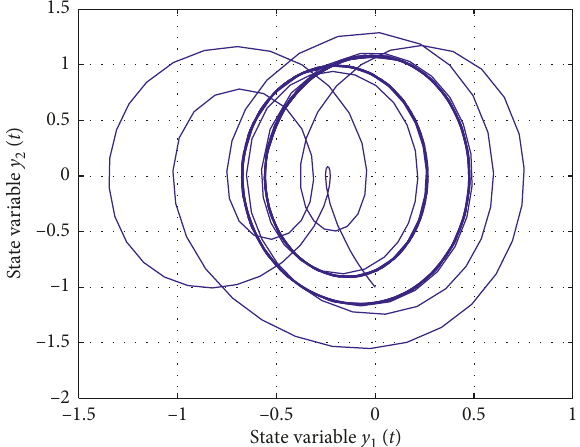
Figure 5: The phase diagram of the chaotic Φ 4 Duffing